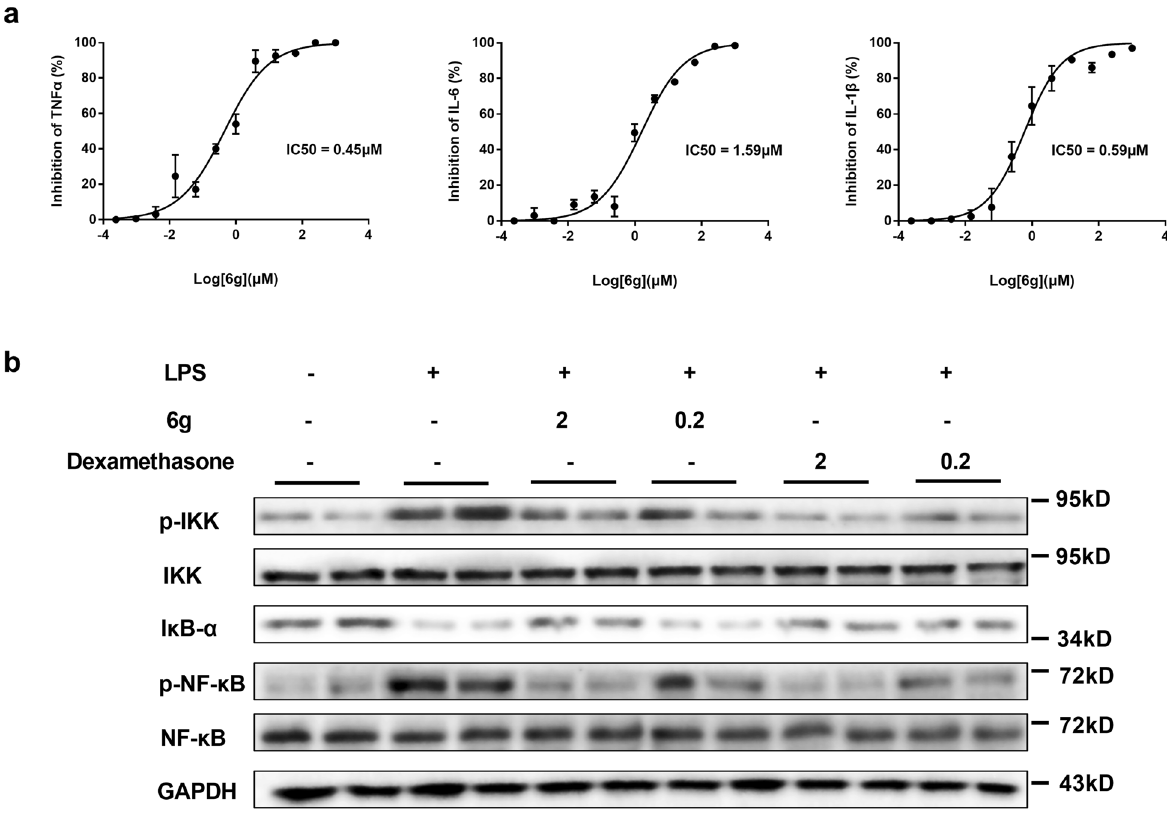
Fig. 6 Compound 6g suppressed the LPS-induced in fl ammatory responses in RAW264.7 macrophages. IC 50 : the concentration of the compound needed to inhibit in fl ammatory mediators by 50% relative to the control value. a Effect of 6g on LPS-induced TNF- α , IL-6, and IL-1 β . Cells were treated with LPS alone (5 μ g/mL) or with indicated concentrations of 6g for 24 h. b Effect of 6g on LPS-induced NF- κ B activation. Dexamethasone was used as a positive control. IC 50 values were calculated by nonlinear regression (curve fi t) applied log (inhibitor) vs. normalized response. Data are shown as the mean ± SEM, n = biologically independent three wells for cytokine assays and two wells for Western blotting examined over two independent experiments.